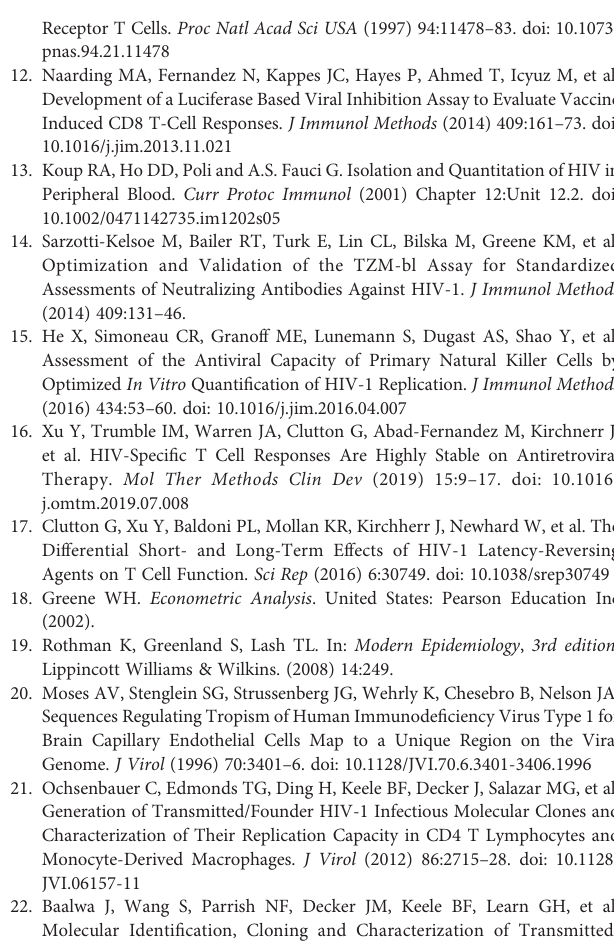
Supplementary Figure 1 | (A) %p24 levels in JR-CSF infected CD4 T cells or autologous CD8-depleted PBMC at day 6 post-infection (n=6, p=0.0313; two- tailed, exact Wilcoxon signed-rank test). (B) Correlation between HIV-speci fi c T cell response (CTLA+CTLB) measured in ex vivo IFN- g ELISpot and %IFN- g + by ICS (n=8, r=0.82, p=0.0122; two-tailed Spearman ’ s rank